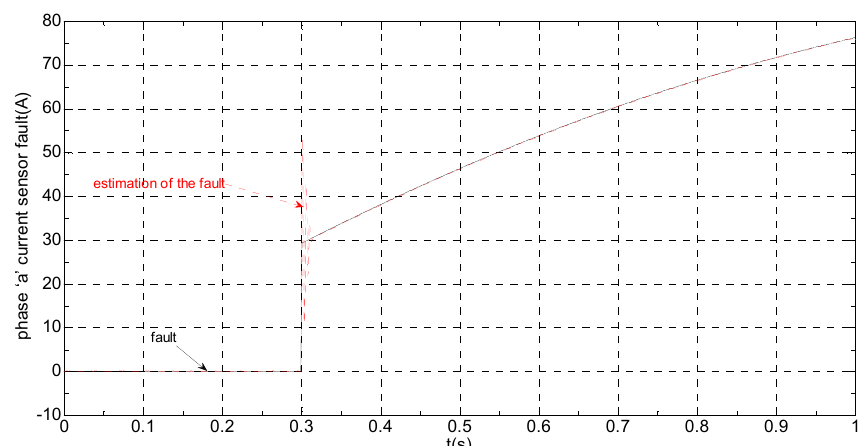
Figure 12. The current sensor fault and its reconstruction in phase “a”.